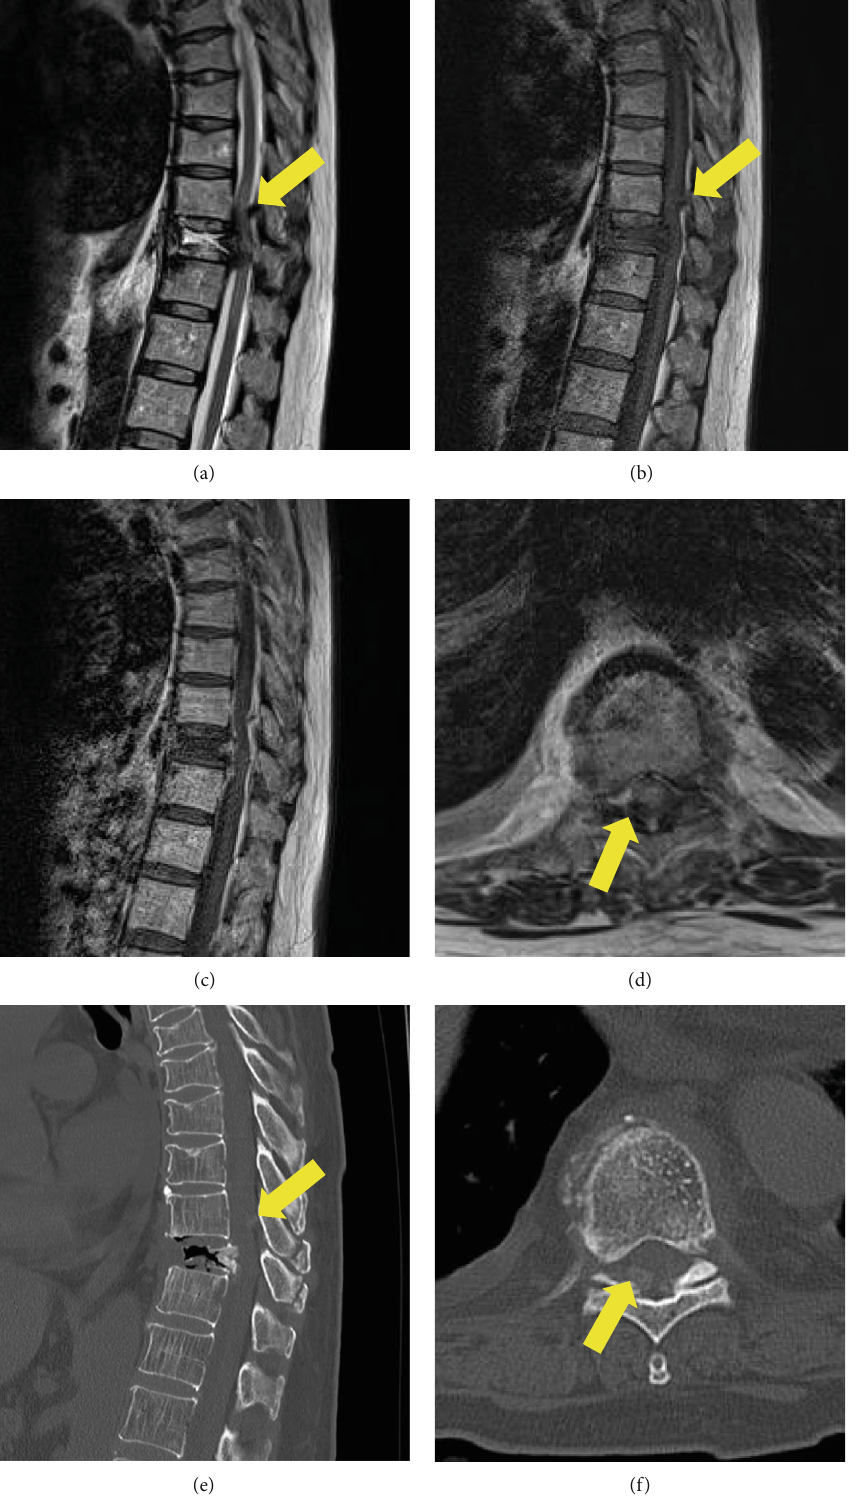
Figure 2: (a) T2 sagittal image showing a growing extradural mass (yellow arrow) at T9 level. (b) T1 sagittal image. (c) T1-enhanced sagittal image. (d) T2 axial image. (e) Computed tomography (CT) sagittal image demonstrating burst fracture of T10 vertebral body and slightly high-intensity mass at T9 level (yellow arrow). (f) CT axial image demonstrating mass e ff ect at the right facet joint (yellow